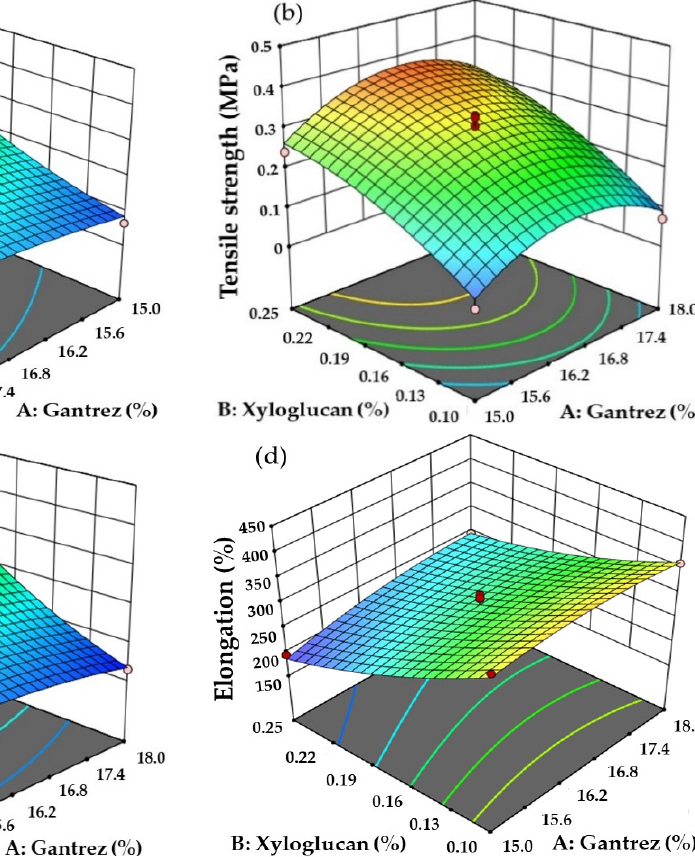
Figure 1. The 3D response surface plots of outputs: ( a ) water absorption, ( b ) tensile strength, ( c ) Young’s modulus, ( d ) elongation, ( e ) erosion, and ( f ) water content. Figure 2. The optimized films ( a ) before and ( b ) after crosslinking at 130 °C for 30 min. 3.2. Embedding of D. bulbifera Extract to Optimized Film For the extract loading, sodium hydroxide solution was added in the optimized mix- ture. After the mixture was cast into molds, dried, and crosslinked, the dried films were